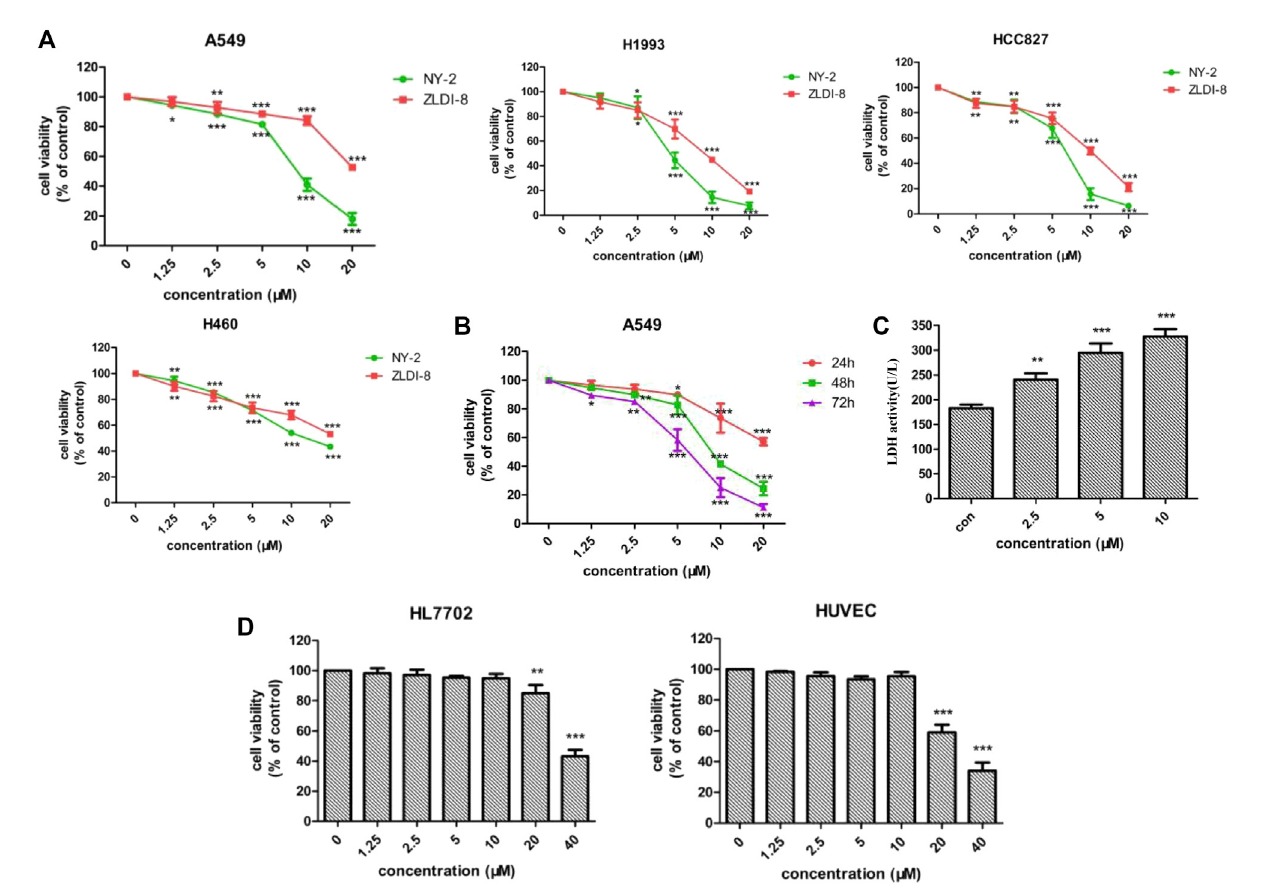
FIGURE 4 Cytotoxic effects of NY-2 and ZLDI-8 on NSCLC cells. Effect of NY-2 and ZLDI-8 on the survival of A549, H1993, HCC827, and H460 (NSCLC) cells at 48 h (A) . NY-2 effect on survival of A549 cells at 24, 48, and 72 h (B) . NY-2 effect on LDH activity of A549 cells (C) . NY-2 effect on survival of HL7702 and HUVECs (normal human cells) for 48 h (D) . * p < .05, ** p < .01, *** p < .001 ( n = 3, mean ± SD).